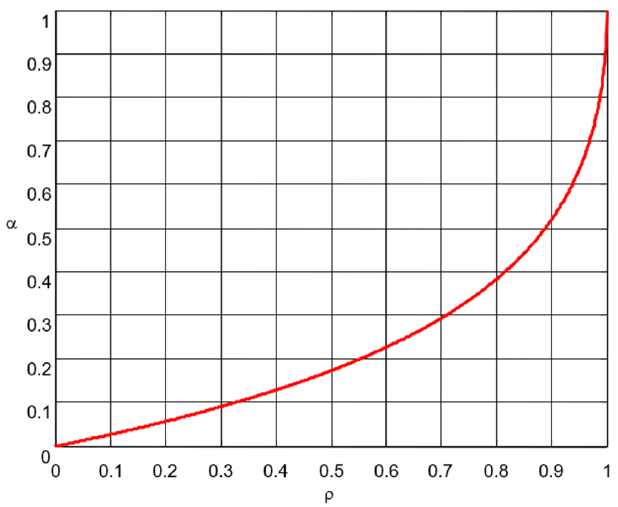
Figure 13. BSF as a function of BLF .